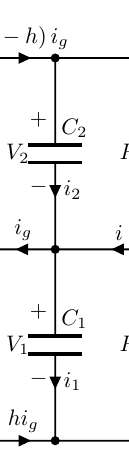
Figure 11. Average circuit model of the equalizer when V 2 > V 1